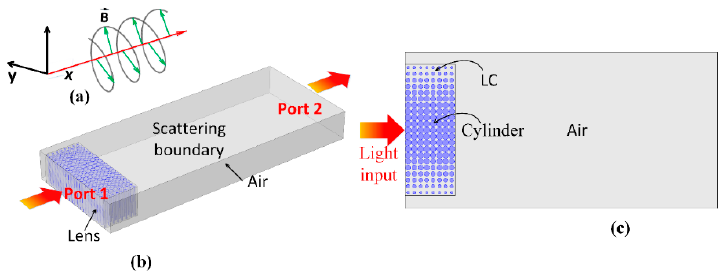
Figure 3. ( a ) The direction of the magnetic field vibration in the light wave. ( b ) 3D structure model ( c ) 2D structure model.